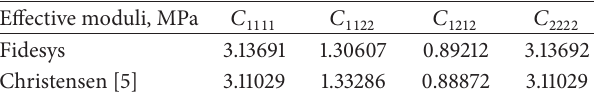
Table 1: Linear effective elastic modulus of the fiber-reinforced composite.AcomparisonbetweentheFidesyscomputationsandthe results of Christensen [5].